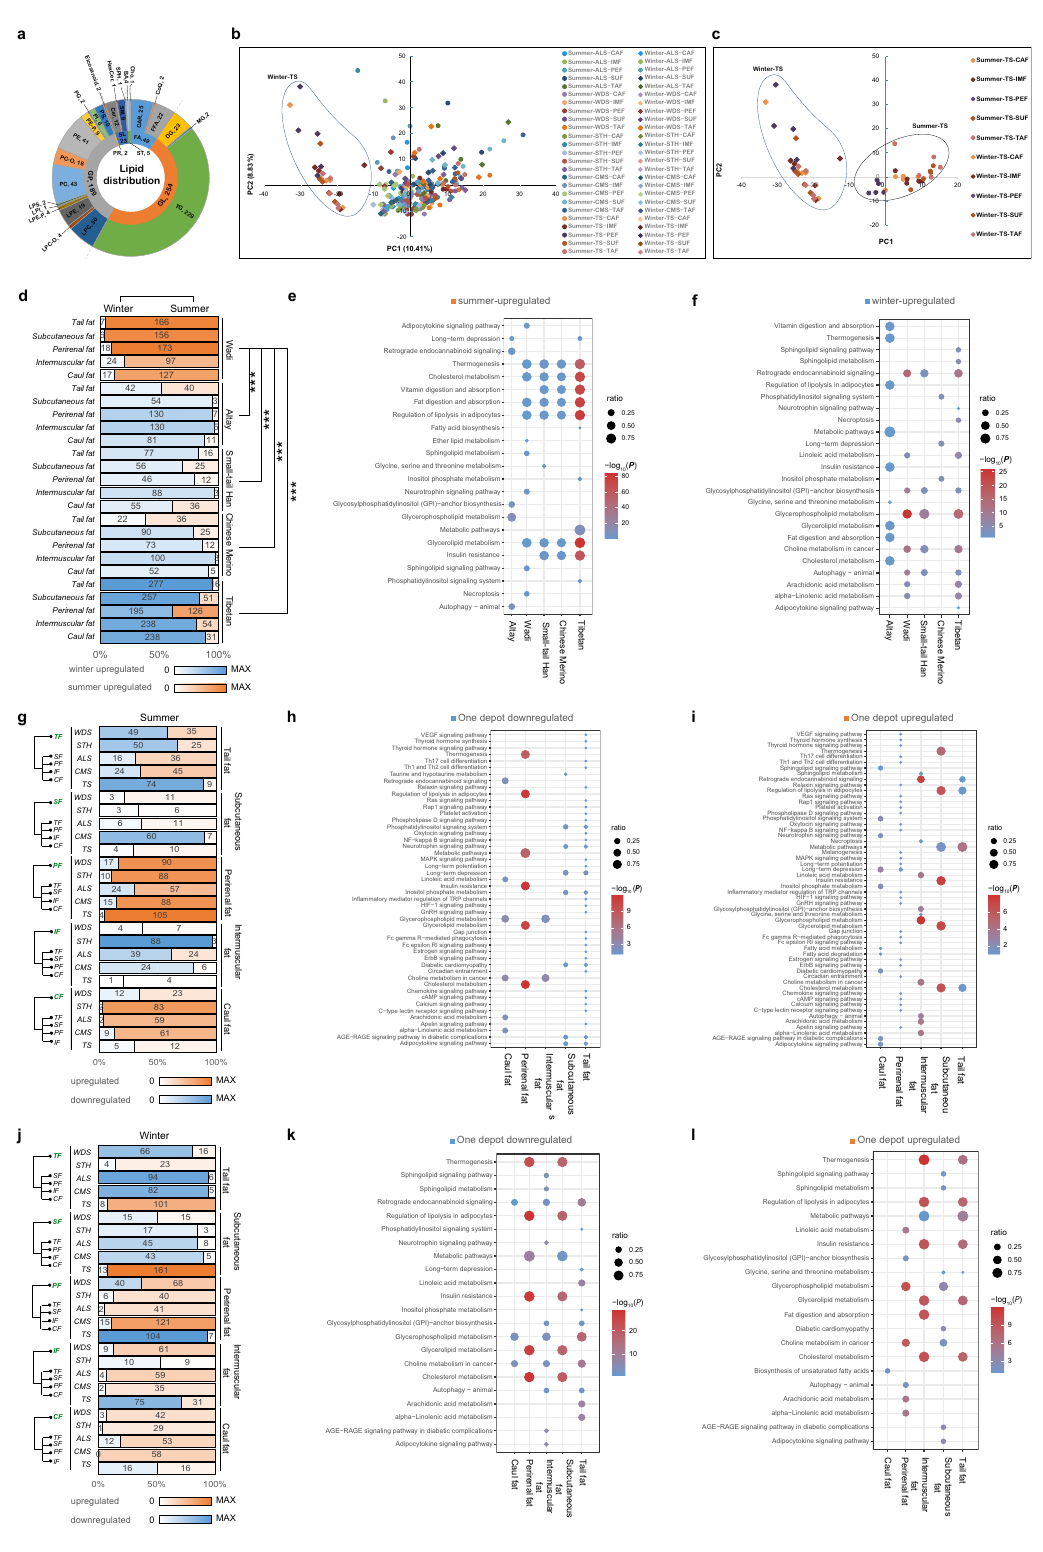
identi fi ed among populations ranged from 1 (for intermuscular fat of Tibetan sheep) and 105 (for perirenal fat of Tibetan sheep) (Fig. 3g and Supplementary Data 24). The upregulated and downregulated lipid metabolites were related to thermogenesis, regulation of lipolysis in adipocytes, metabolic pathways, and glycerolipid metabolism (Fig. 3h, i and Supplementary Data 25,